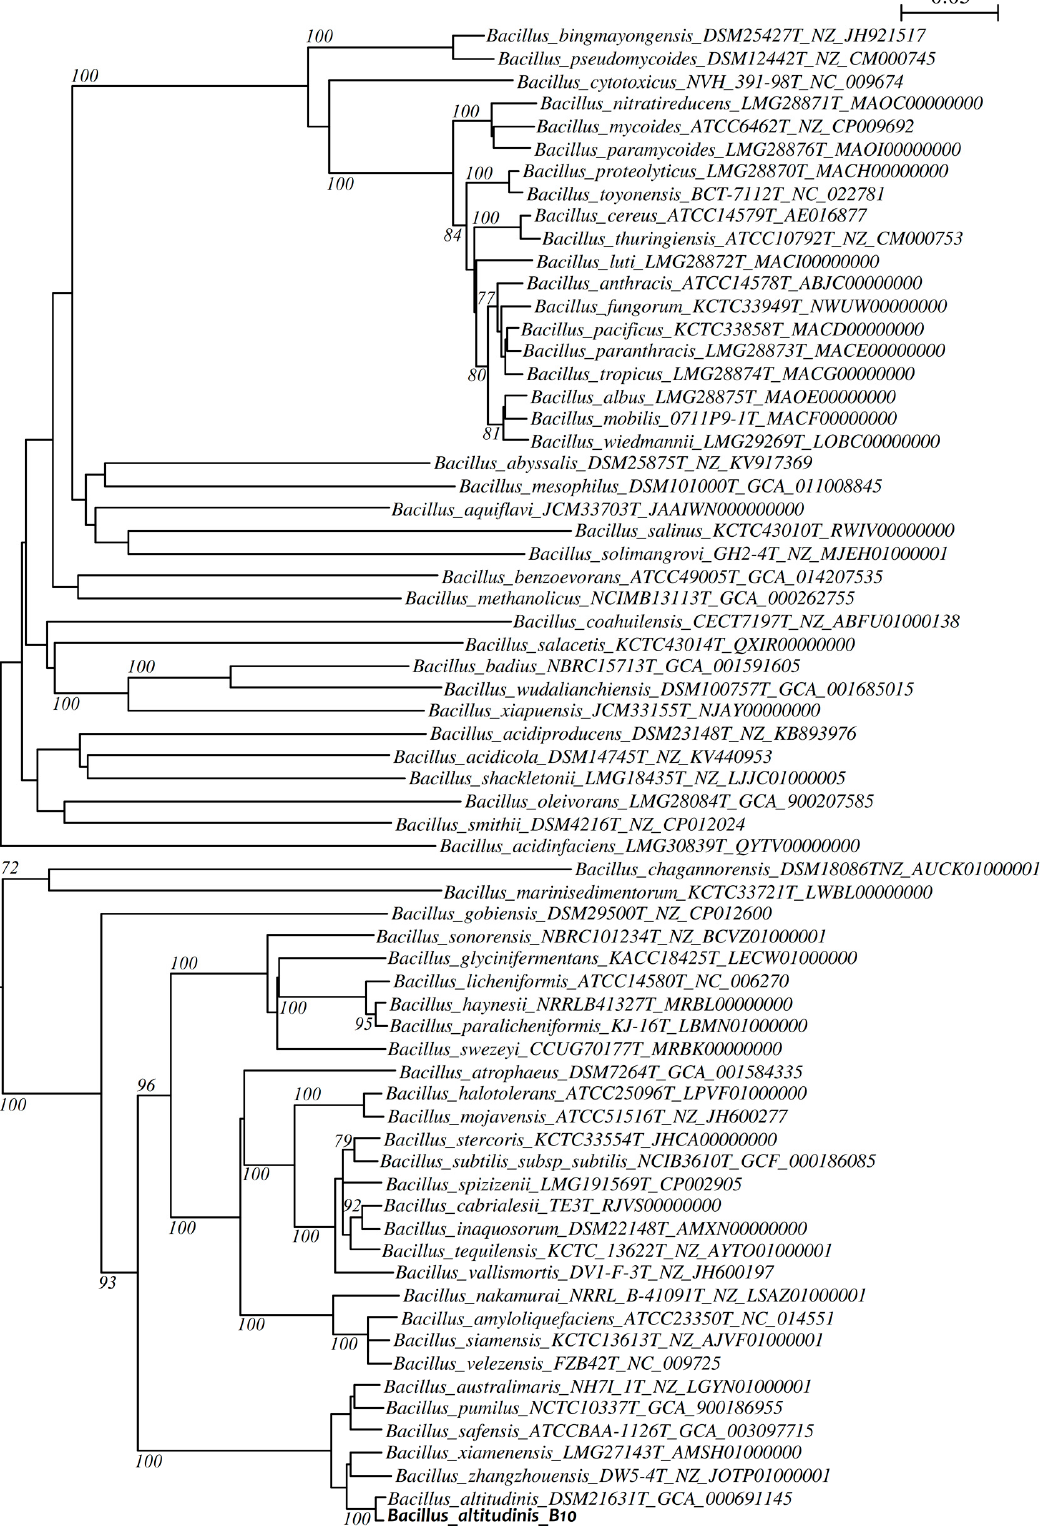
Figure 4. Neighbor-joining phylogenetic tree based on cdaA gene sequences showing the positions of the B10 isolate B. altitudinis and the type strains of the genus Bacillus. Bootstrap values >70 are shown above branches. Bar: 0.05 substitutions per nucleotide position. Sequence accession numbers are given following strain